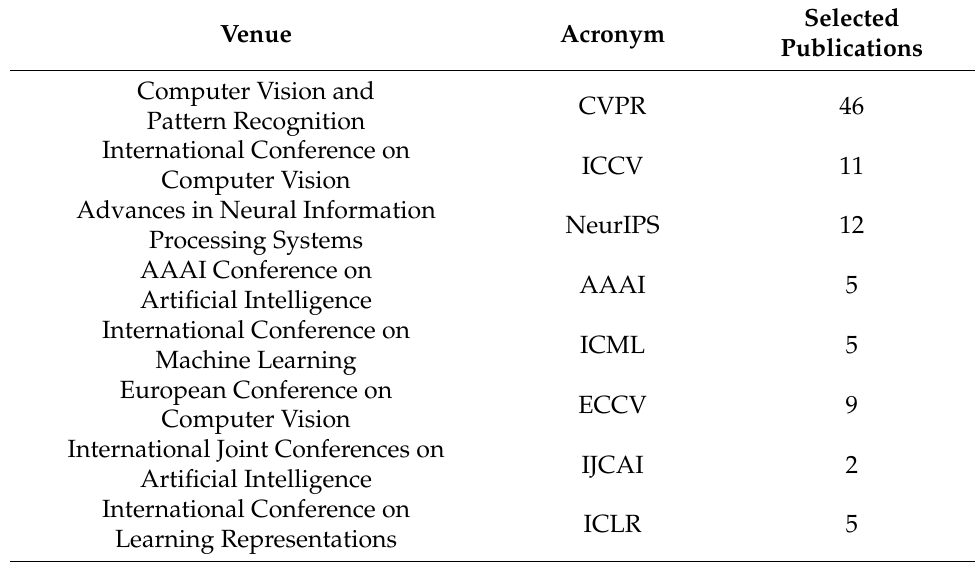
Table 1. Targeted venue for manual